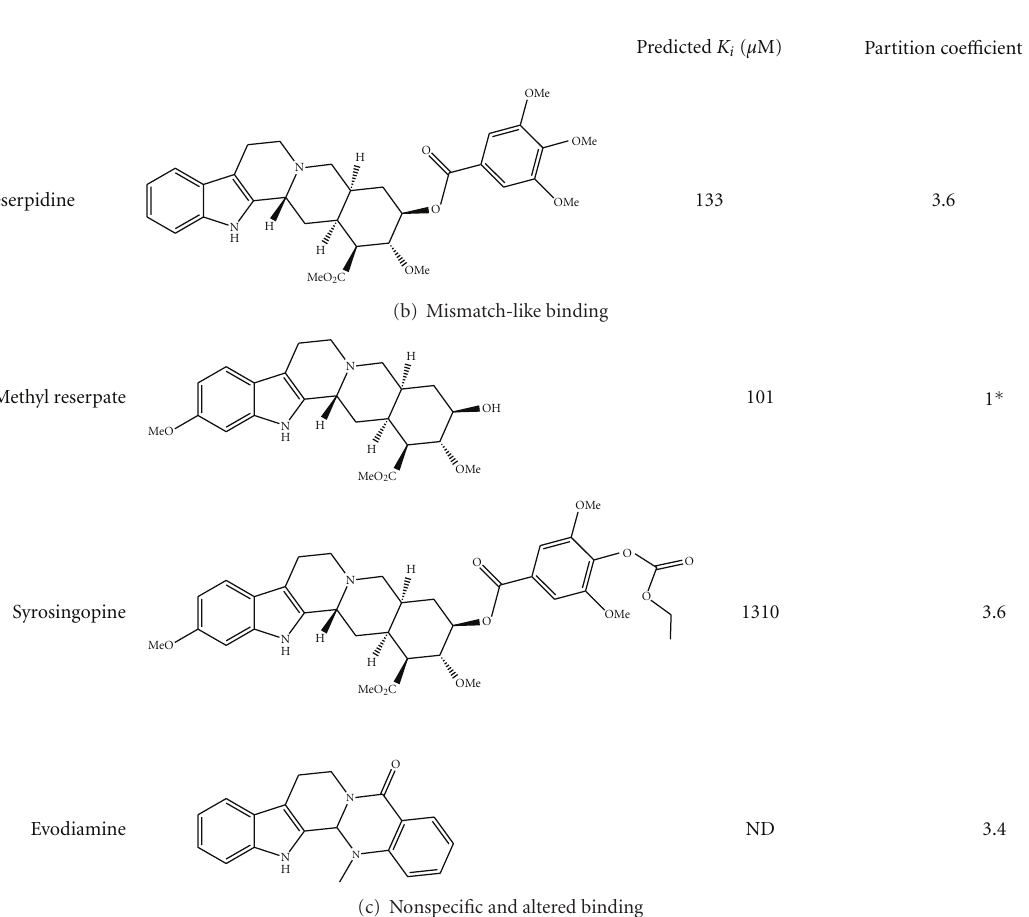
Figure 4: Structures of reserpine and rescinnamine derivatives are shown on the left and their corresponding predicted (calculated, as described in Section 2) binding constants and partition coe ffi cients are displayed on the right. Derivatives are subdivided into their predicted binding modes: (a) flipped; (b) mismatch-like; and (c) nonspecific or altered (see also Figure